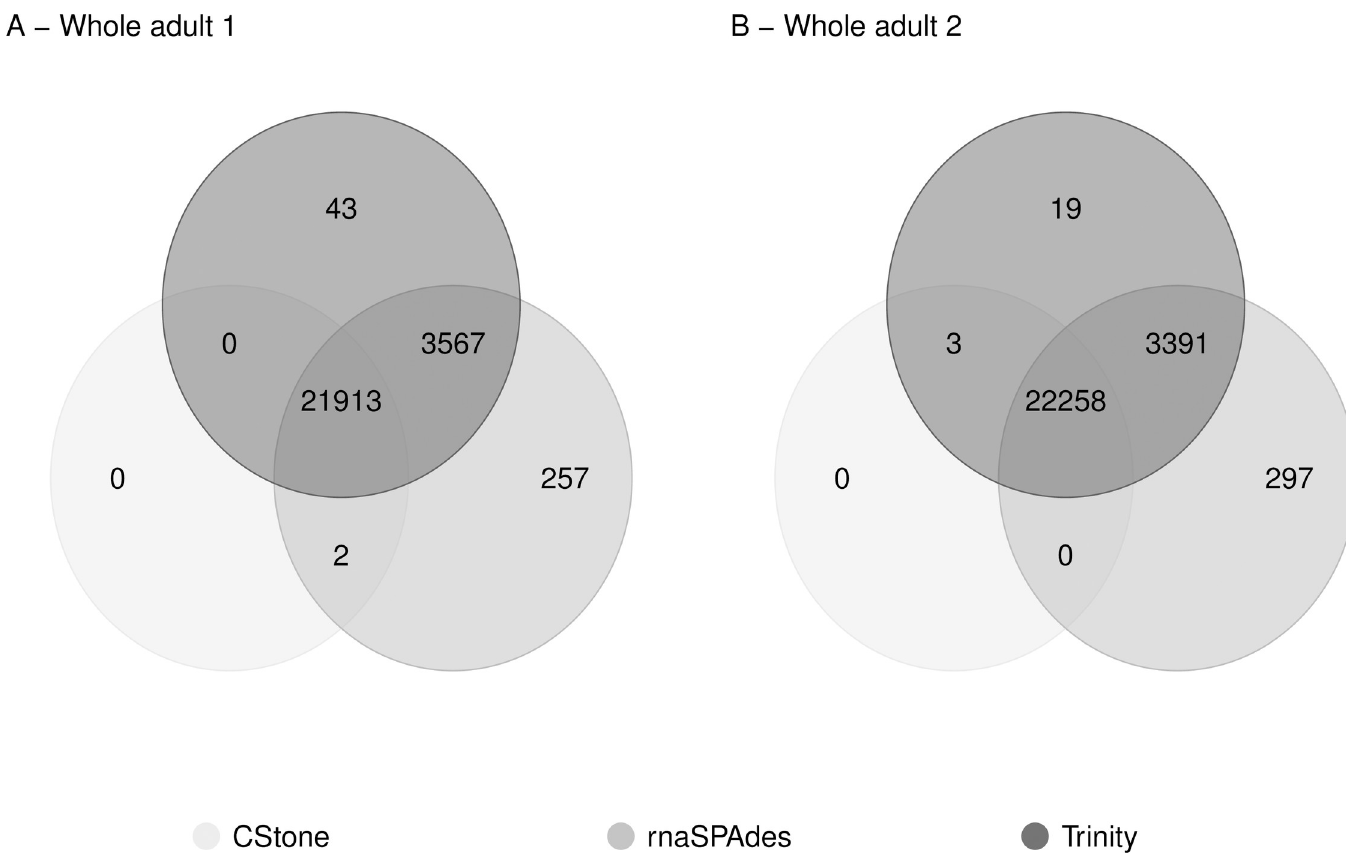
Fig 13. Agreeability between assemblers. Venn diagram showing the extent to which contigs produced by each assembler, when run on real data, agree in their representation of the species-specific cDNA reference transcripts. The key indicates the colour of the circle representing each assembler.